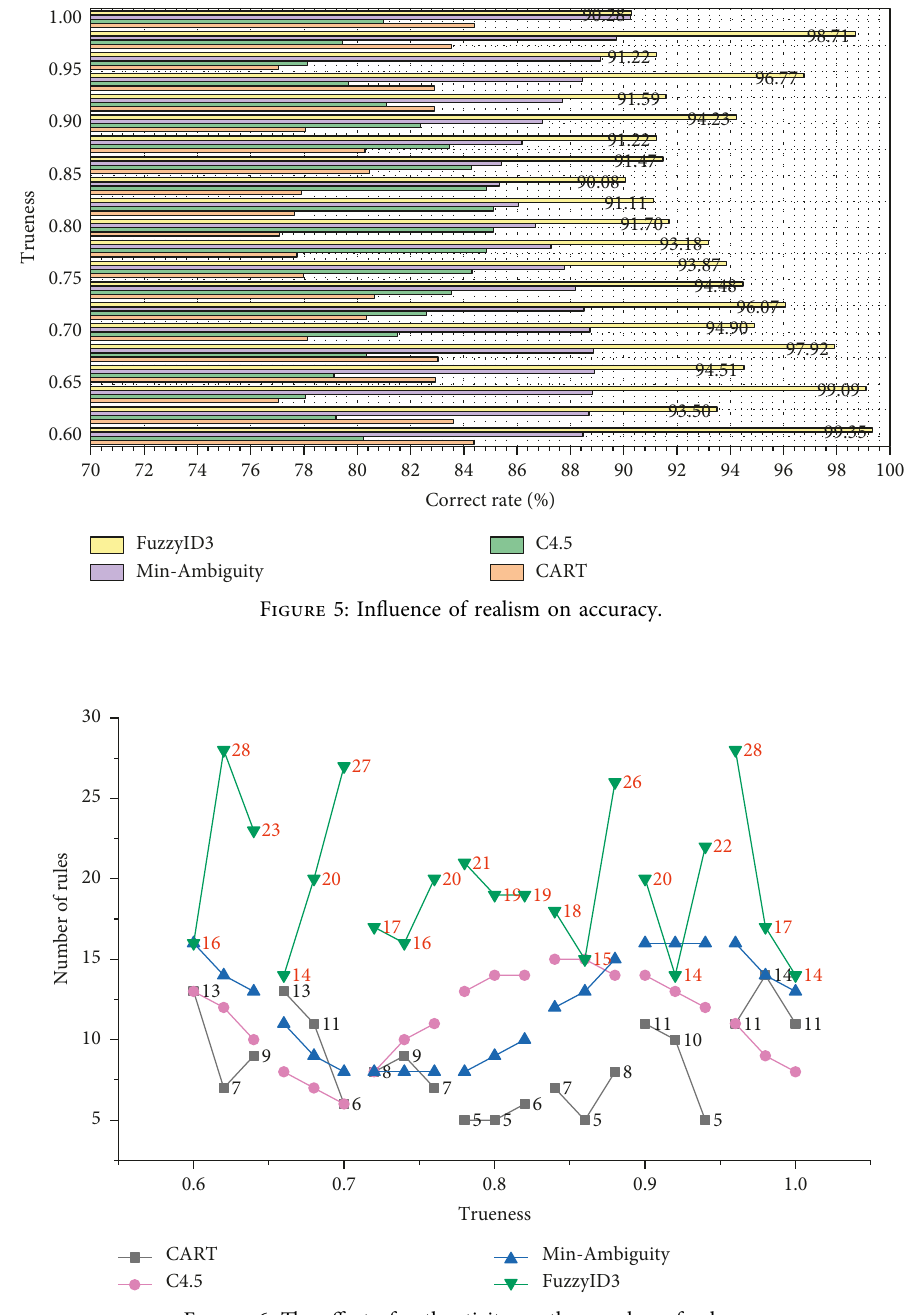
Figure 6: The effect of authenticity on the number of rules.